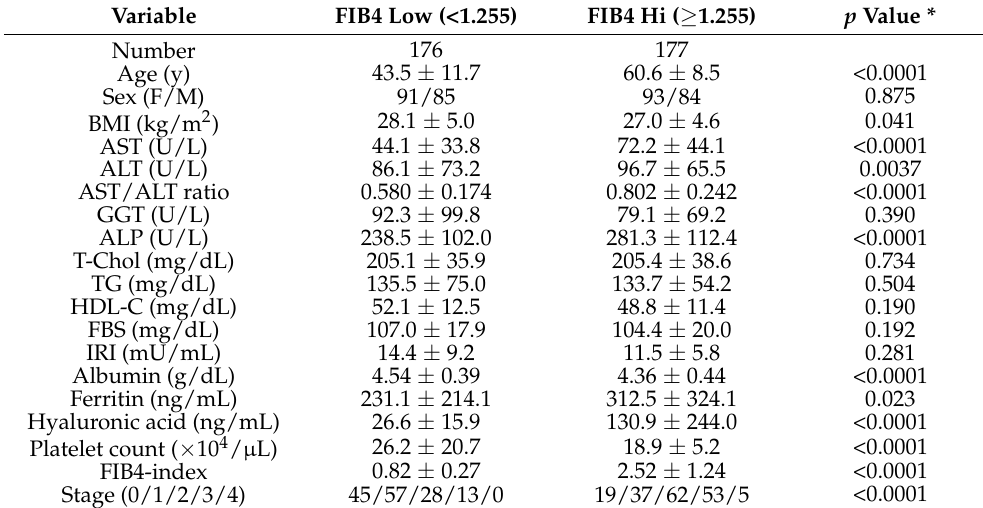
Table 1. Liver biopsy data of study subjects.